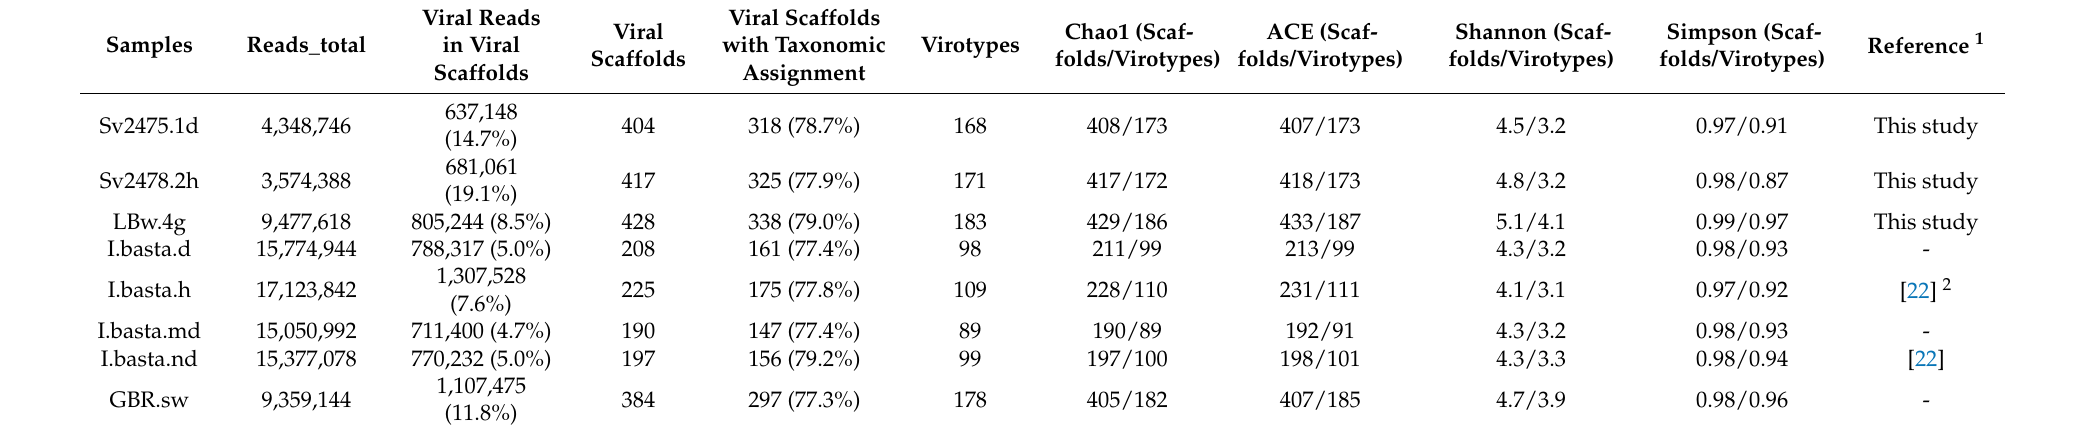
Table 2. General statistics and viral diversity indices for the datasets used in the study.